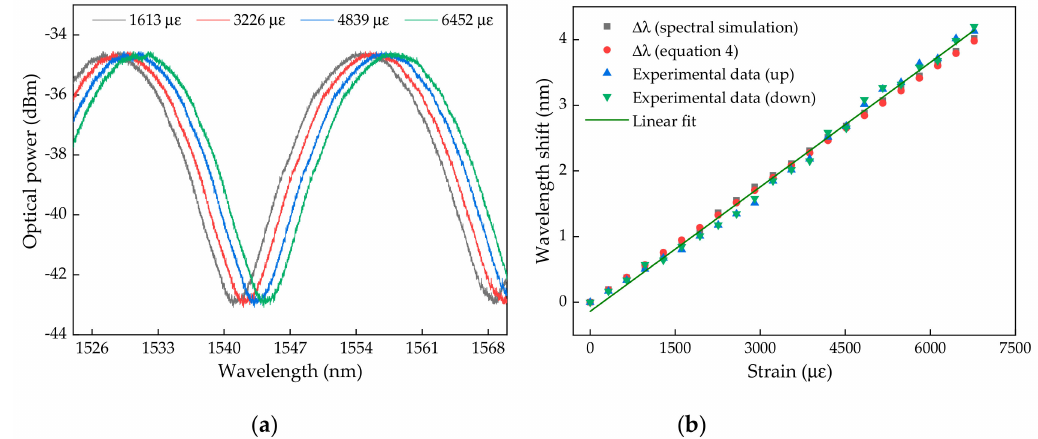
Figure 8. ( a ) Optical spectra acquired for 4 di ff erent elongation values; ( b ) Comparison of the wavelength shift obtained experimentally and theoretically as a function of the applied strain. The linear fit represented corresponds to the fit made at the “Experimental data (down)”.